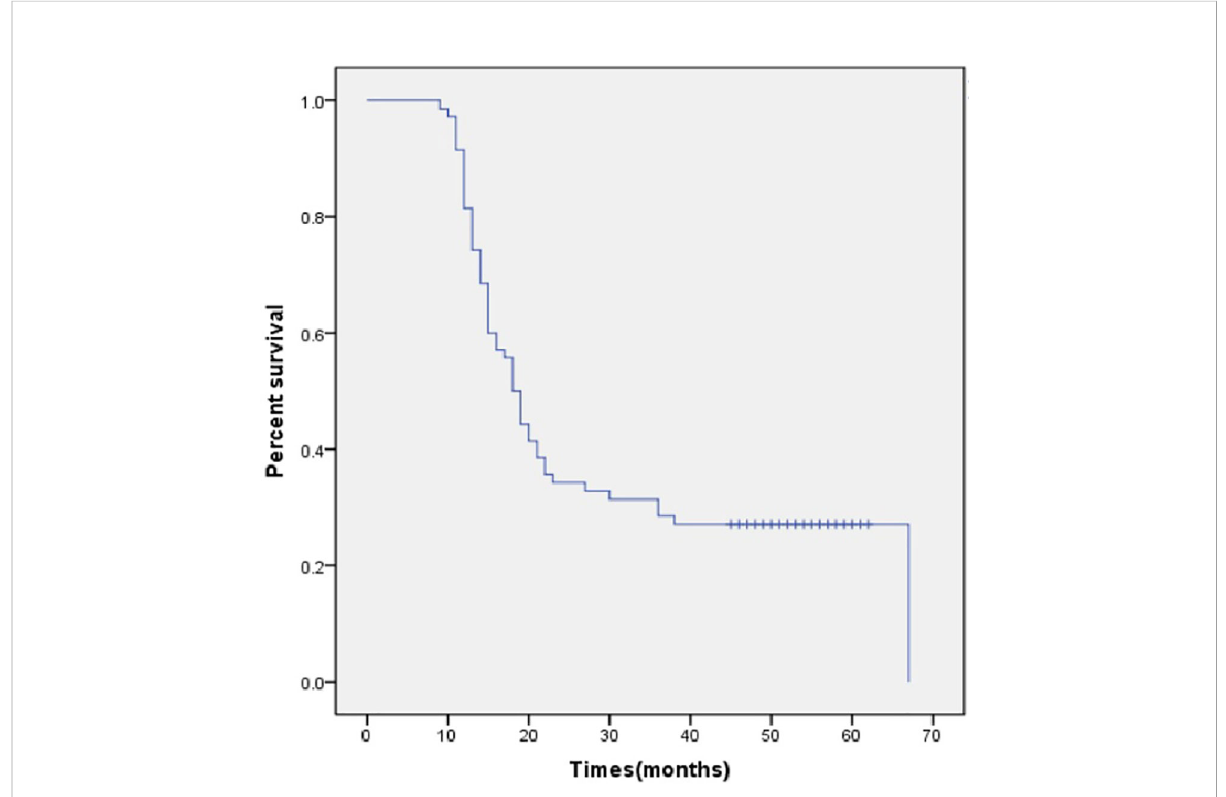
FIGURE 2 Overall survival in